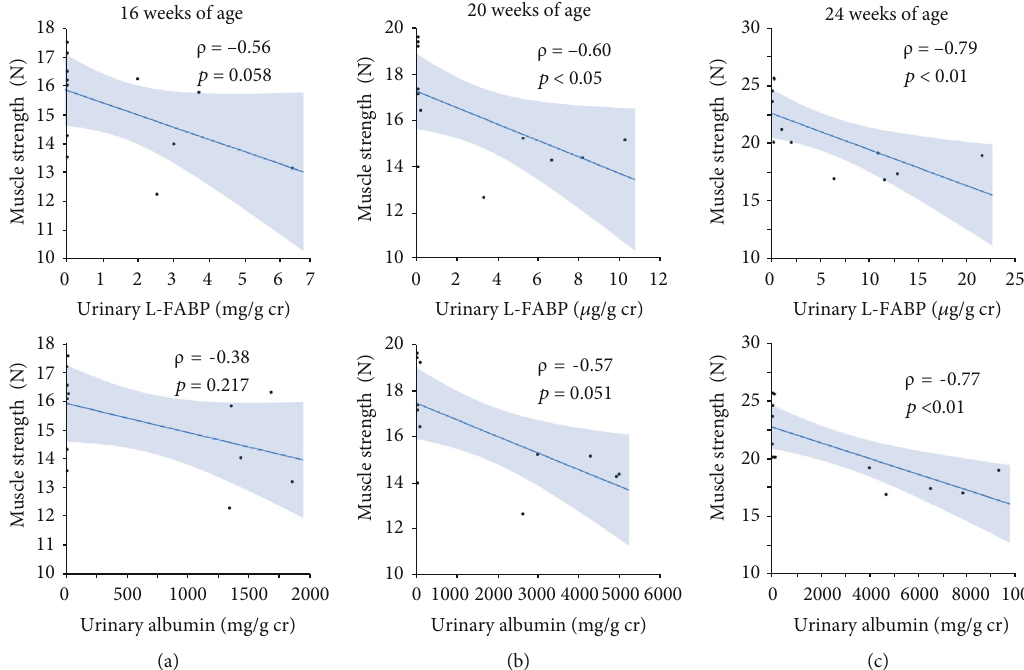
Figure 6: Correlations between each urinary marker and muscle strength at 16 (a), 20 (b), and 24 weeks of age (c).